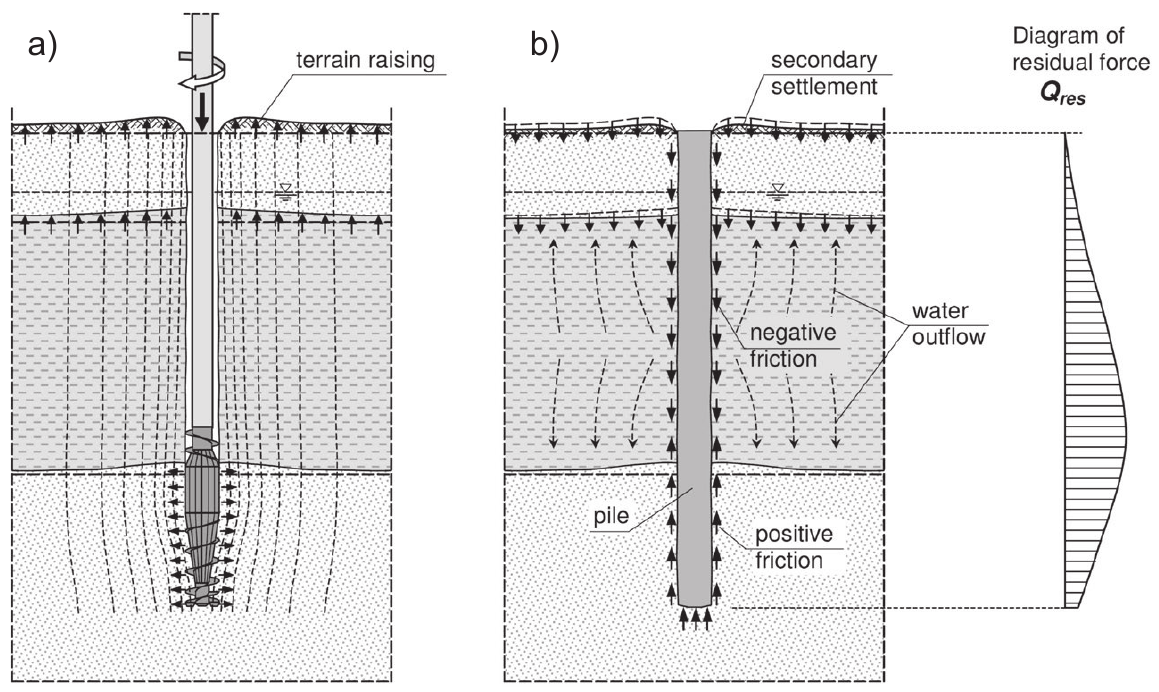
Figure 3: The mechanism of residual force generation in a screw displacement pile: a) phase of soil spreading by the auger, b) phase after the pile is completed and the concrete has hardened.